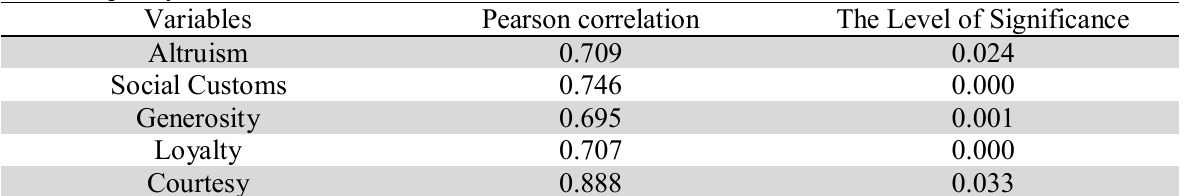
The summary of Pearson correlation test beteen organization citizenship behavior and perceived service